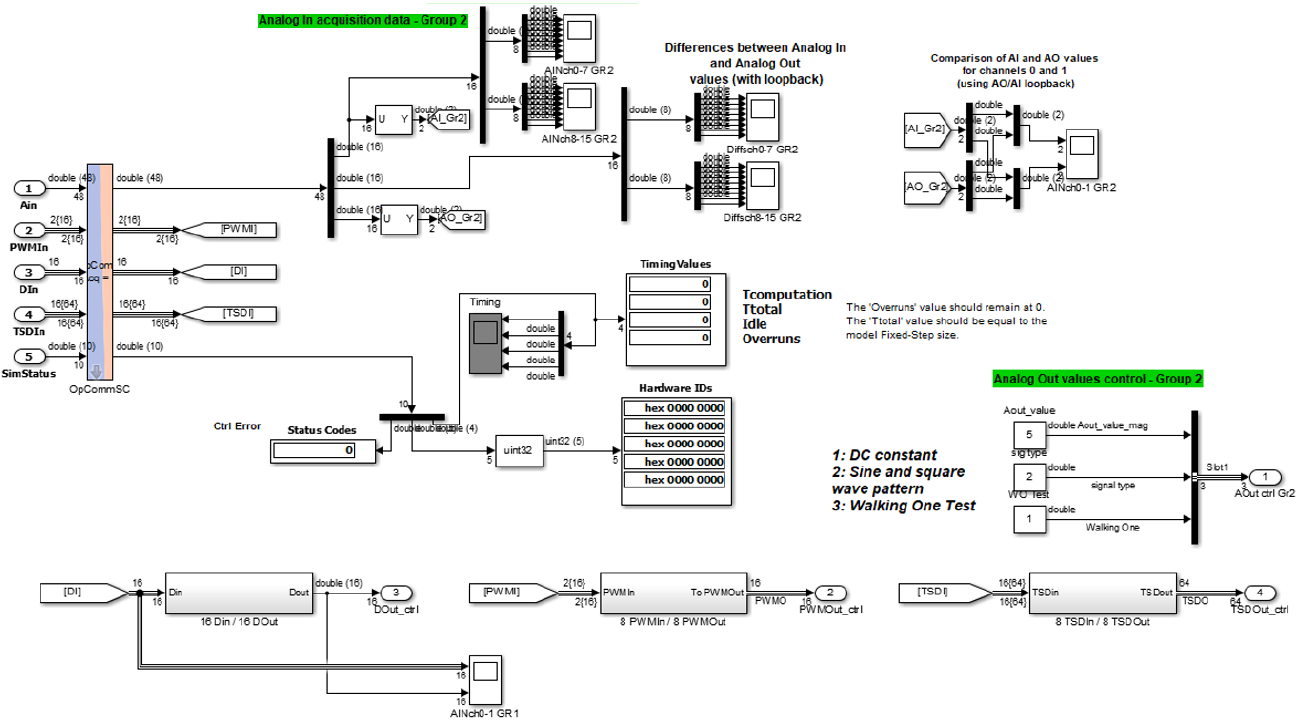
Figure 5. Realtime OPAL RT components design.